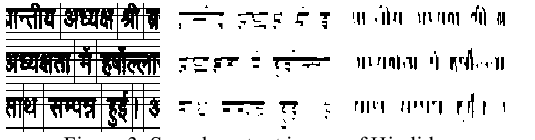
Figure 3. Sample output image of Hindi